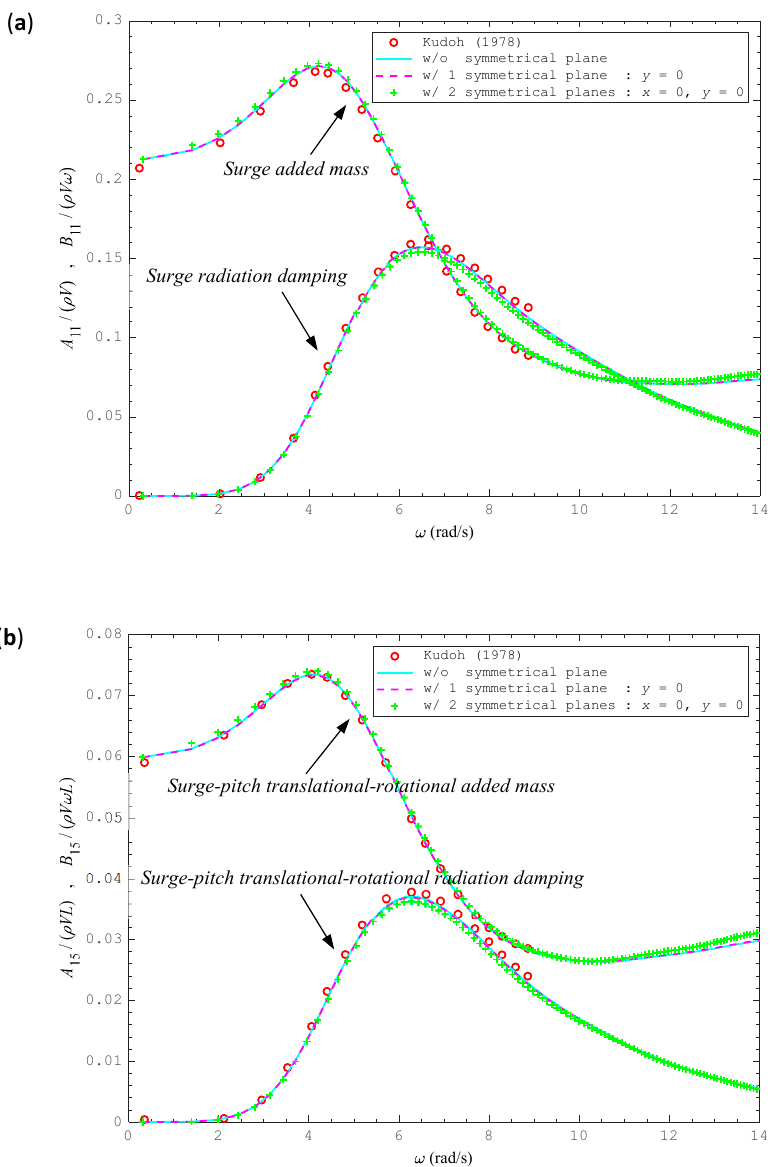
Figure 8. Added mass and radiation damping coefficients of a floating ellipsoid as a function of the angular wave frequency ω : ( a ) diagonal terms of the surge added mass and radiation damping due to surge motion and ( b ) cross terms of the surge added mass and radiation damping due to pitch motion.